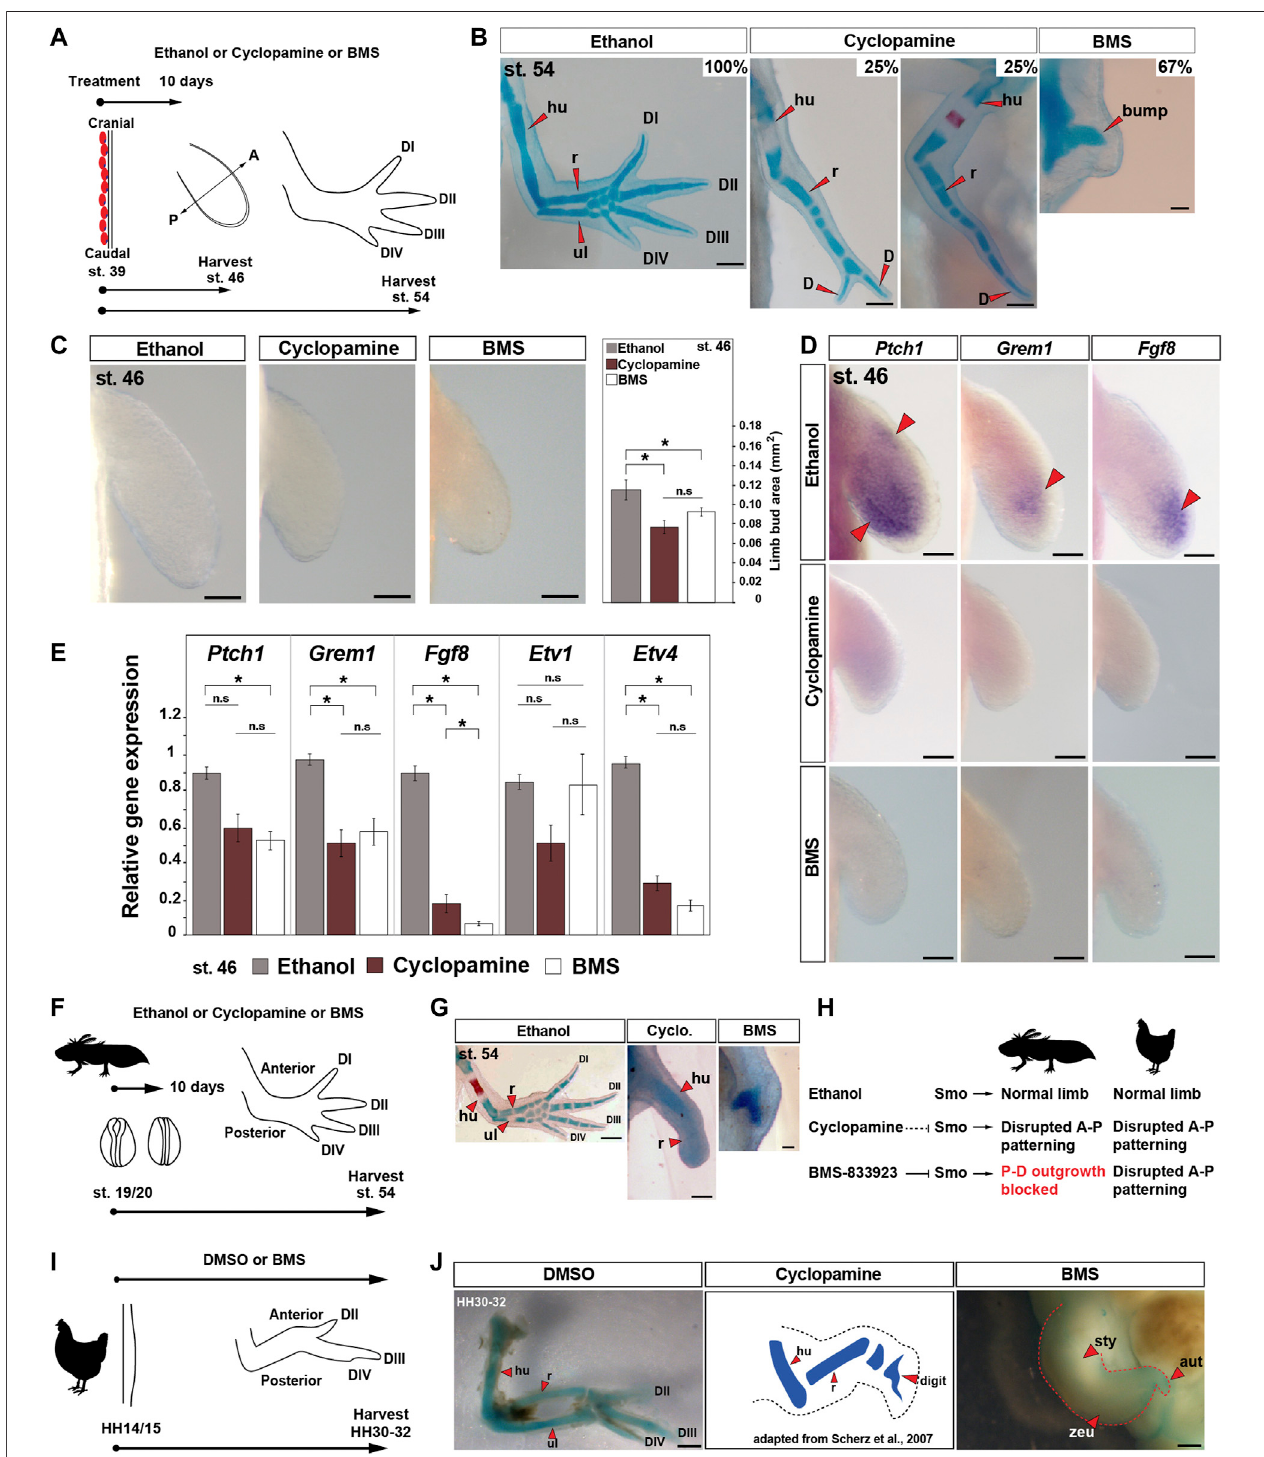
FIGURE 1 | Small-molecule smoothened antagonist BMS-833923 inhibits limb bud outgrowth in axolotl larvae. (A) Design for ethanol (control), cyclopamine, and BMS treatments in axolotl. Limbs are aligned with anterior “ A ” on the top and posterior “ P ” on the bottom. Red ovals depict dorsal muscle blocks. (B) Representative imagesofAlcianblue/Alizarinred – stainedethanol-,cyclopamine-,orBMS-treatedstage54limbs(limb n =30forethanol,24forcyclopamine,and36forBMS-833923). Scale bar = 500 µm. (C) Limb bud area measurements in ethanol (control)-, cyclopamine-, or BMS-treated limbs [one-way ANOVA, Tukey – Kramer HSD post hoc test, F = 8.628; Tukey – Kramer HSD post hoc test, p = 0.0026 (ethanol vs. cyclopamine), p = 0.046 (ethanol vs. BMS), and p = 0.34 (cyclopamine vs. BMS); n = 6 per